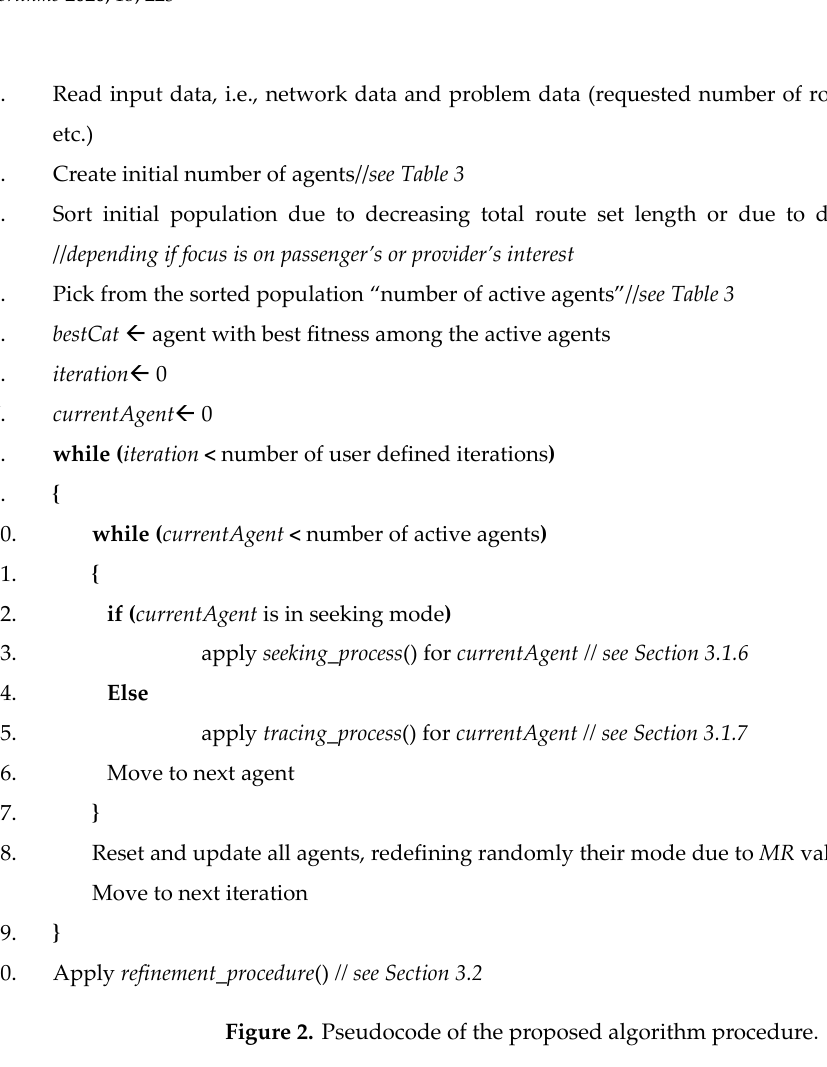
Figure 2. Pseudocode of the proposed algorithm procedure.